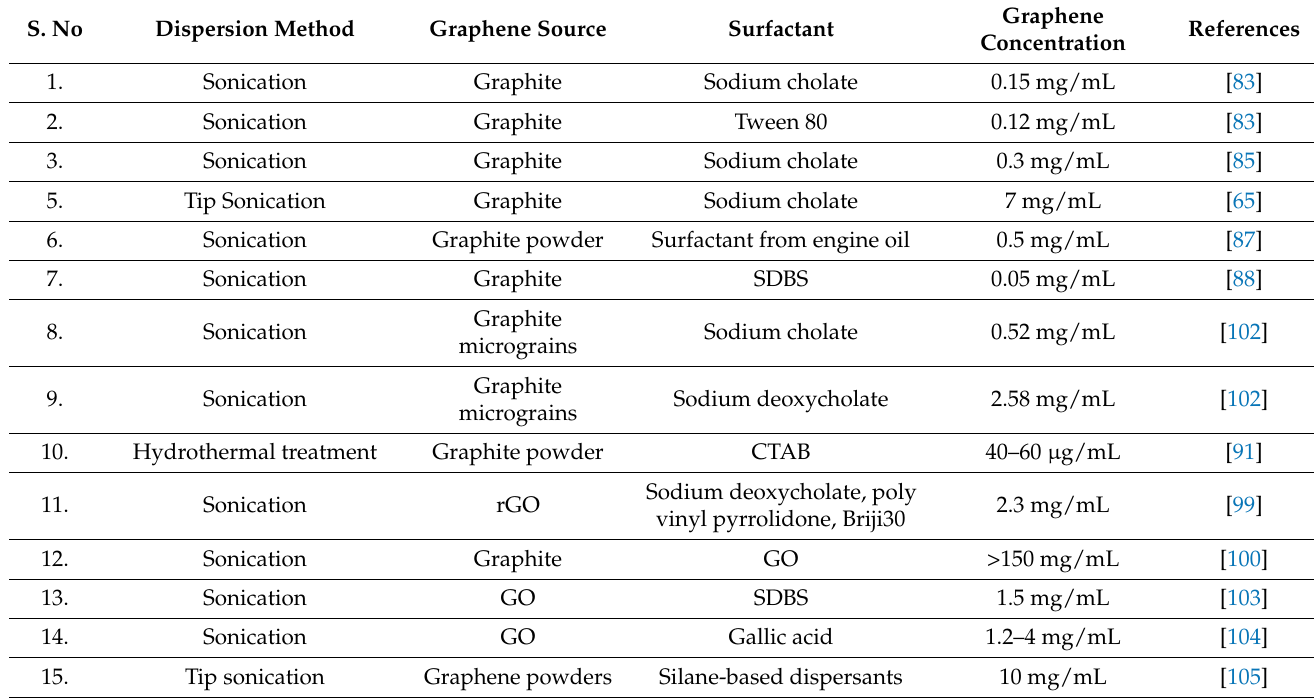
Table 2. A comparison details of dispersion method, graphene source, surfactants, and graphene concentration values. S.